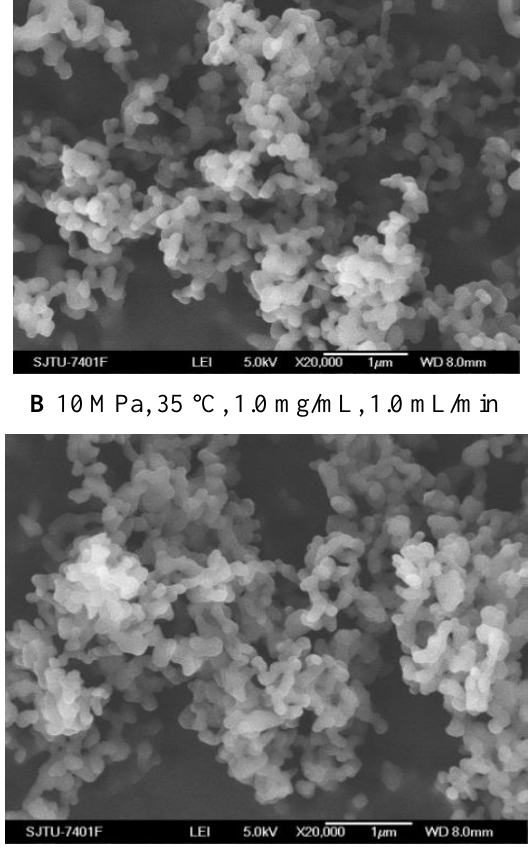
C 12 MPa, 35 °C, 1.0 mg/mL, 1.0